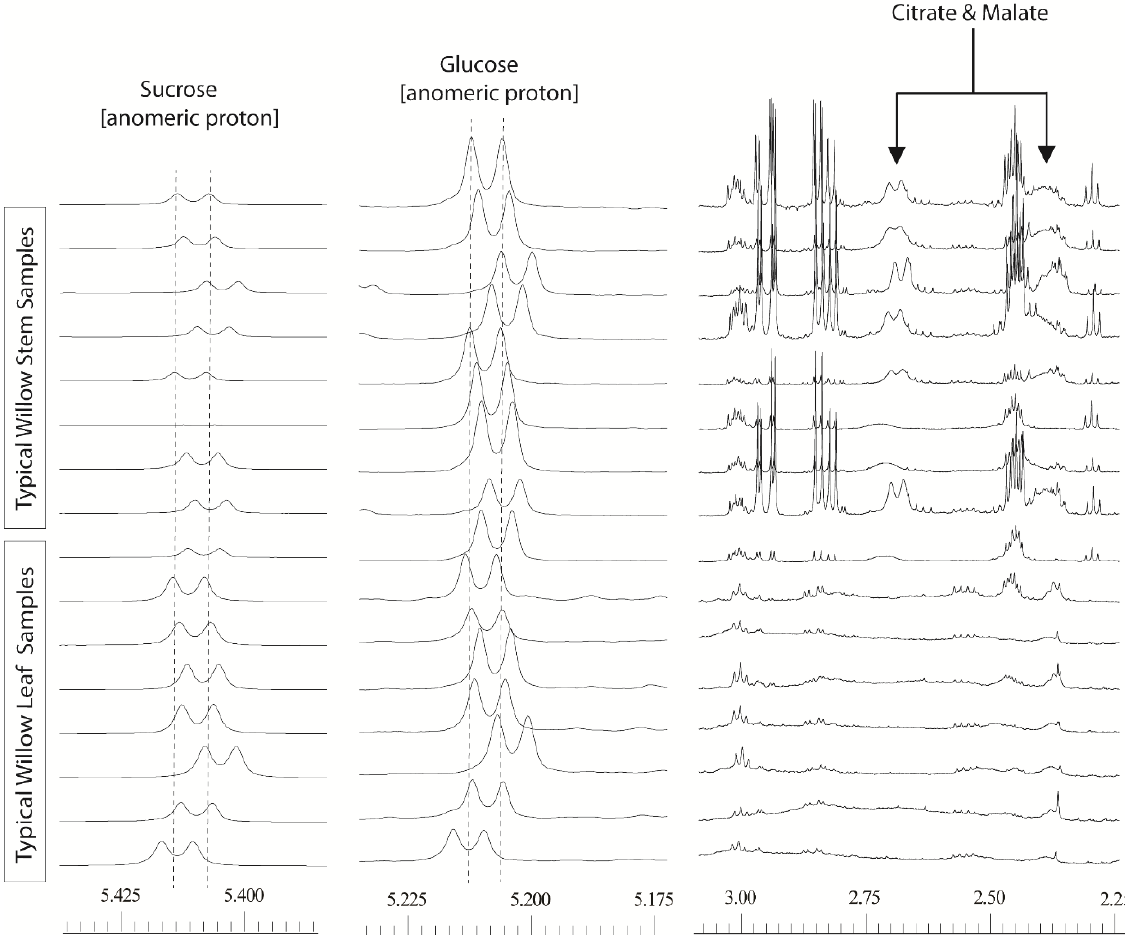
Figure 1. 600 MHz 1D 1 H-NMR willow leaf and stem spectra, from a polar solvent extraction using 80:20 D 2 O:CD 3 OD: illustrating chemical shift variation in anomeric sucrose (δ5.425–5.400) and glucose (δ5.225–5.195) signals together with shift variation and broadness in citrate and malate signals